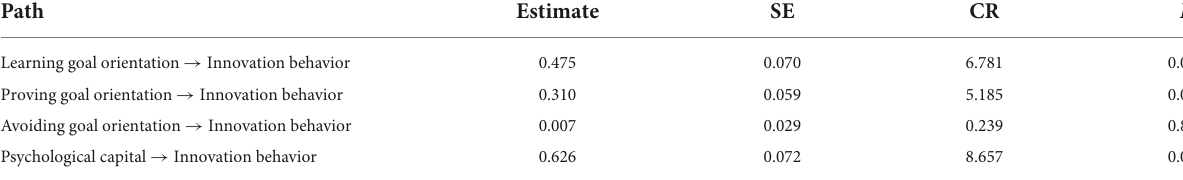
TABLE 5 Mediating effect test of psychological